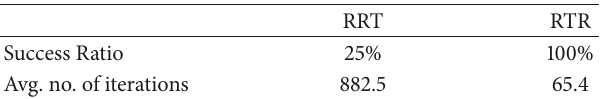
Table 1: Performance measures of RRT and RTR (based on 100